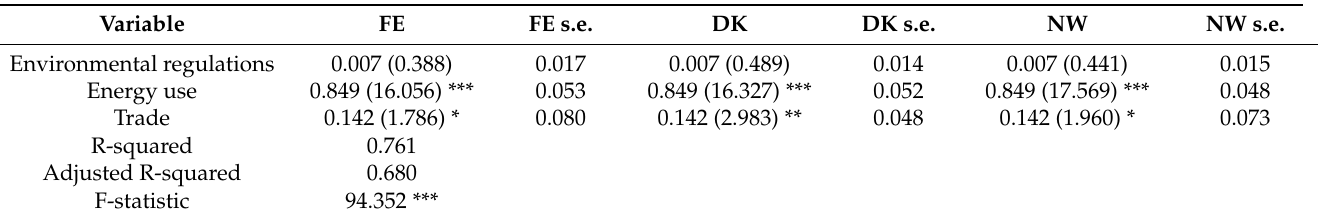
Table 6. Estimations using FE and DK. Independent variables are in logarithmic terms. T-statistics are in parentheses. Dependent variable is ecological footprint in logarithmic terms.